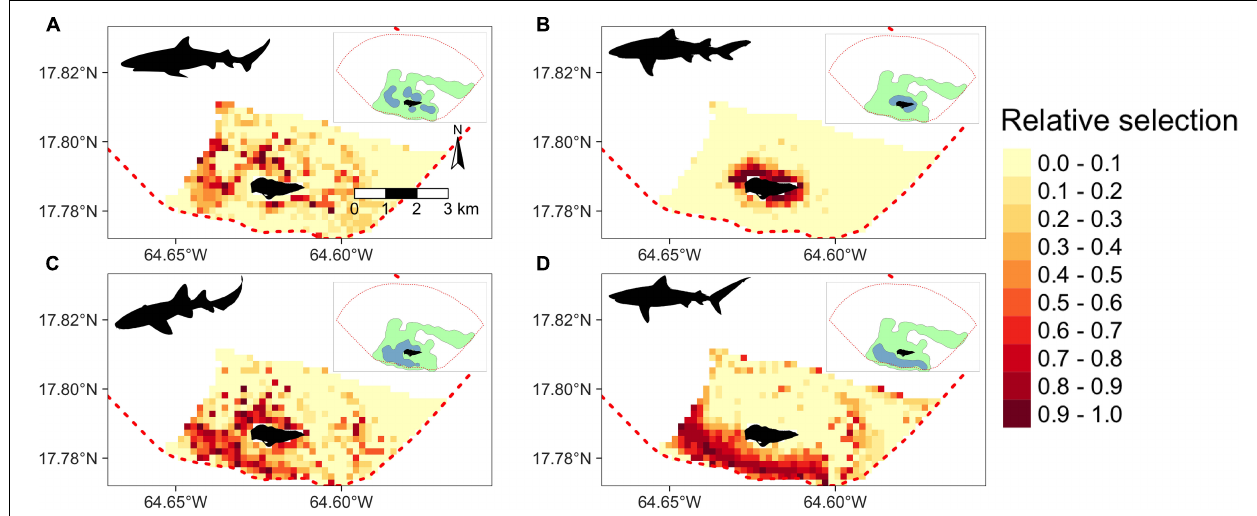
FIGURE 5 | Derived from random forest models, the predicted and extrapolated probability of relative selection across Buck Island National Reef Monument (designated by red dashed line) for (A) Caribbean reef sharks, (B) lemon sharks, (C) nurse sharks, and (D) tiger sharks. Higher and darker values indicate higher relative selection values. Model extrapolation across the study areas restricted to the maximum observed depth for each species. 50% (green) and 95% (blue) kernel density estimates shown in the upper right corner of each plot.